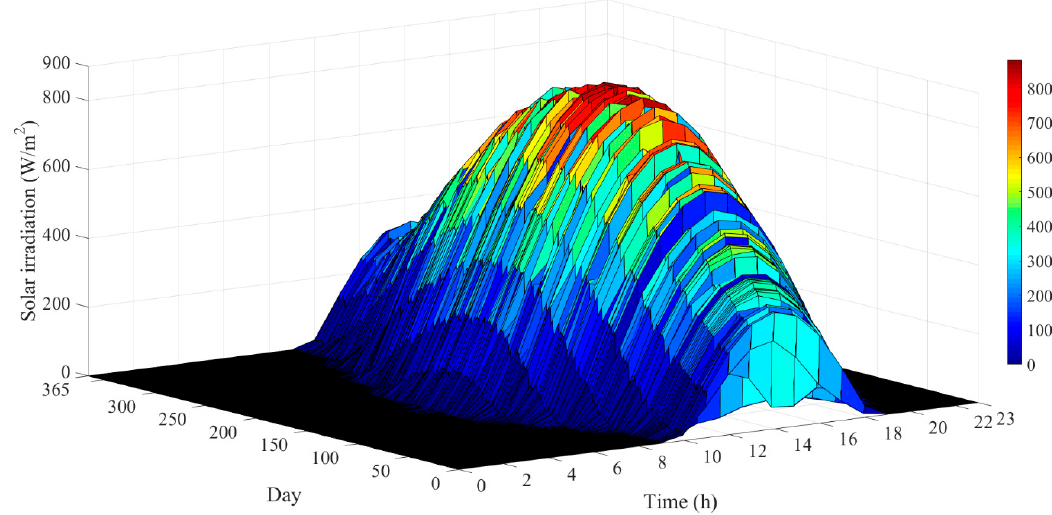
Figure 5. Hourly received solar radiation on horizontal surface data for Brussels.